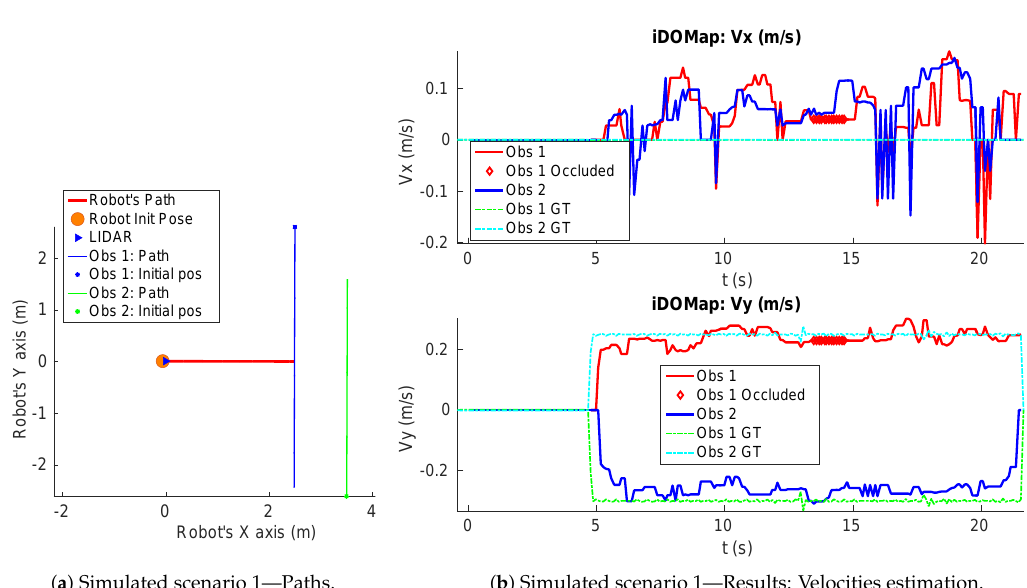
( b ) Simulated scenario 1—Results: Velocities estimation. Figure 10. Simulated scenario 1—Paths and Velocities estimation.